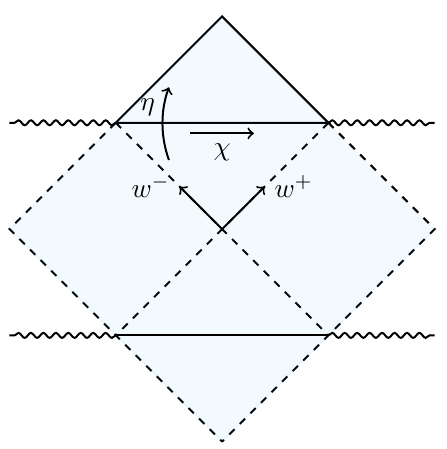
Figure 27 . The conformal field is in the vacuum state of a Minkowski spacetime as shaded in blue, which is conformally equivalent to the original metric. We can parametrize the region with coordinates w ±